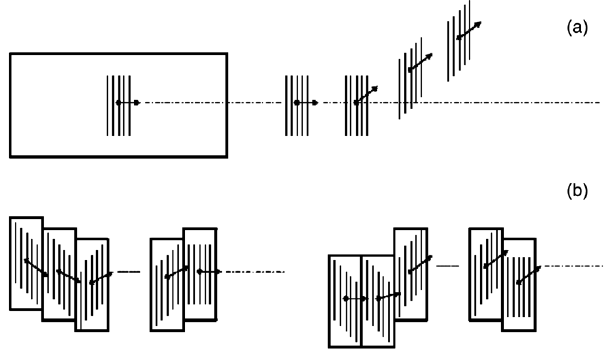
FIG. 1. Effect of a transverse kick on electrons in an undulator. In Tanaka ’ s picture [8] (a), all electrons in the bunch follow the same direction of motion as a whole, before (left side) and after the kick. In our picture (b), instead, different macroslices in the same bunch follow different directions of motion along the undulator by virtue of their initial different launching conditions. These were determined by collective effects in the upstream accelerator. In the sketch, solid lines define the bunch (a) or a macroslice (b); arrows indicate the electrons ’ direction of motion; vertical bars identify the FEL microbunch wave front